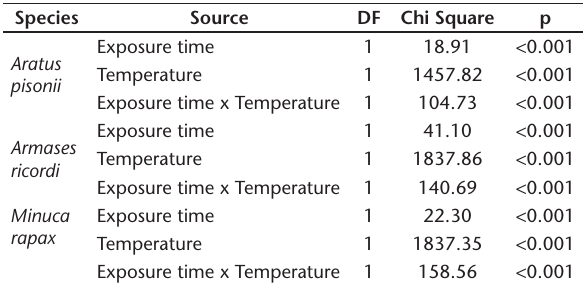
Table 3. Logistic regression of larval survival over time (between 2 and 6 hours) for each species.